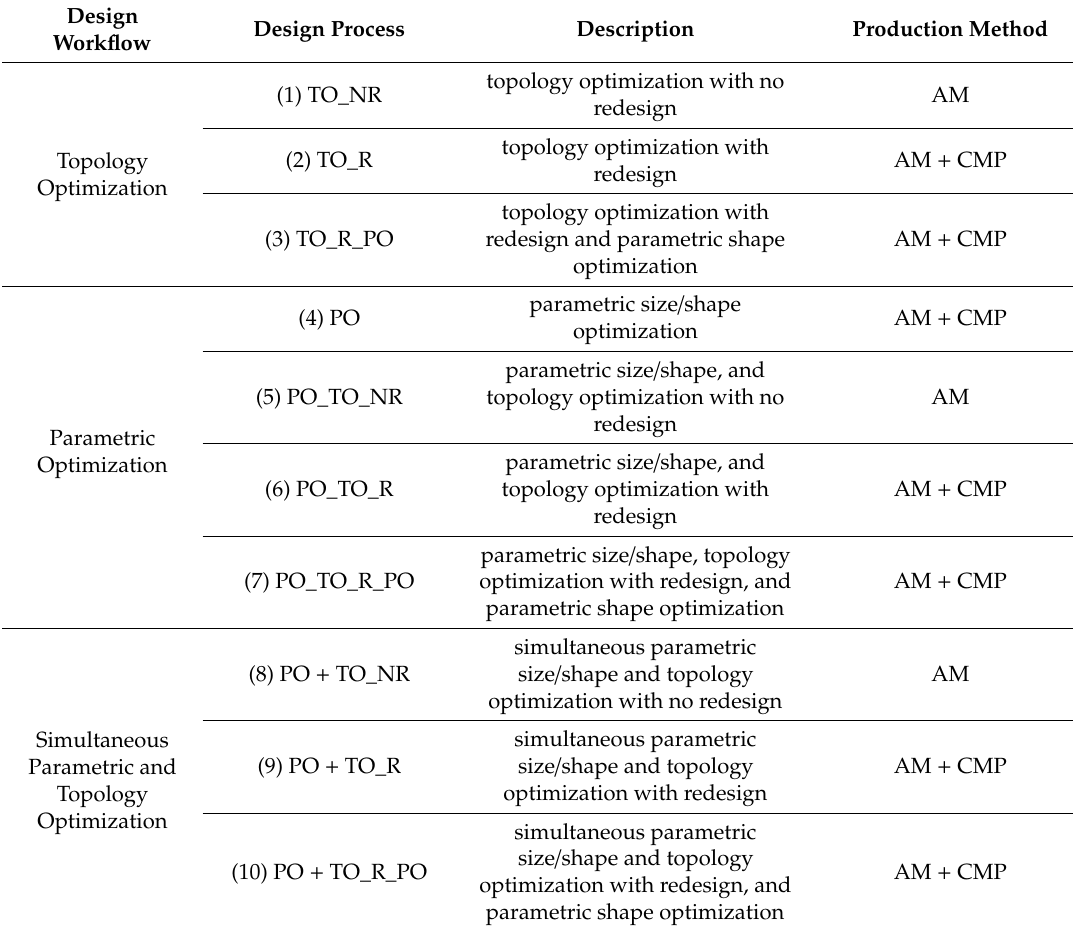
Table 1. The ten implemented design processes, their name, description, and production